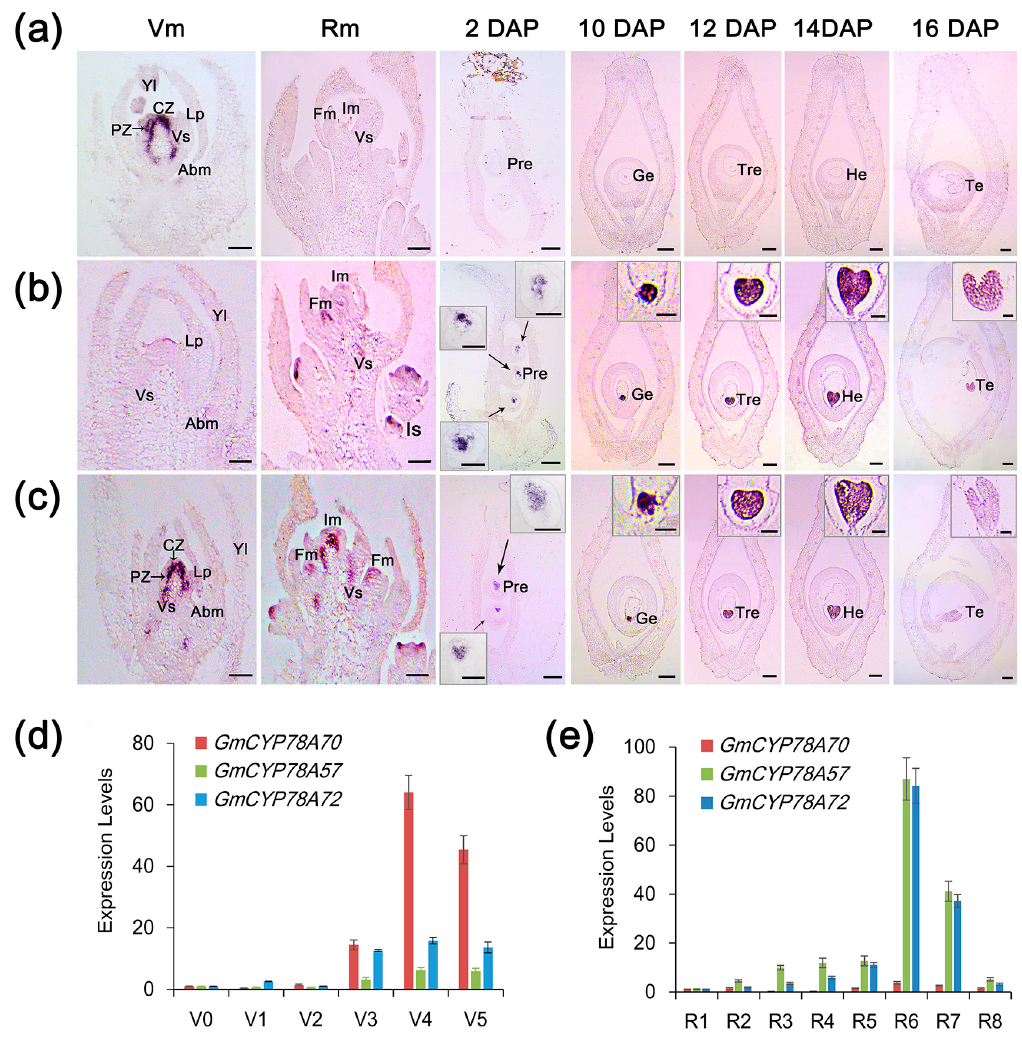
Figure 3. Spatiotemporal expression patterns of GmCYP78A s. ( a – c ) In situ hybridizations of GmCYP78A70 , GmCYP78A57 and GmCYP78A72 were performed respectively in the vegetative meristem (Vm), reproductive meristem (Rm), and the carpel and young pod. Scale bars = 100 µ m. For the boxed insets of ( b , c ) the scale bars = 20 µ m. ( d ) Expression levels of GmCYP78A s at each stage of the vegetative phase (V0–V5). ( e ) Expression levels of the GmCYP78A s at each stage of the reproductive phase (R1–R8). Expression levels at the V0/R1 stage were set to 1, while those at other stages were adjusted accordingly. Data shown are mean ± SE ( n = 3, biological replicates). CZ, central zone; PZ, peripheral zone; Abm, axillary bud meristem; Vs, developing vascular strand; Fm, floral meristem; Im, inflorescence meristem; Is, inflorescence stem; Pre, proembryo; Ge, global embryo; Tre, transition embryo; He, heart embryo; Te, torpedo embryo; DAP: days after pollination.